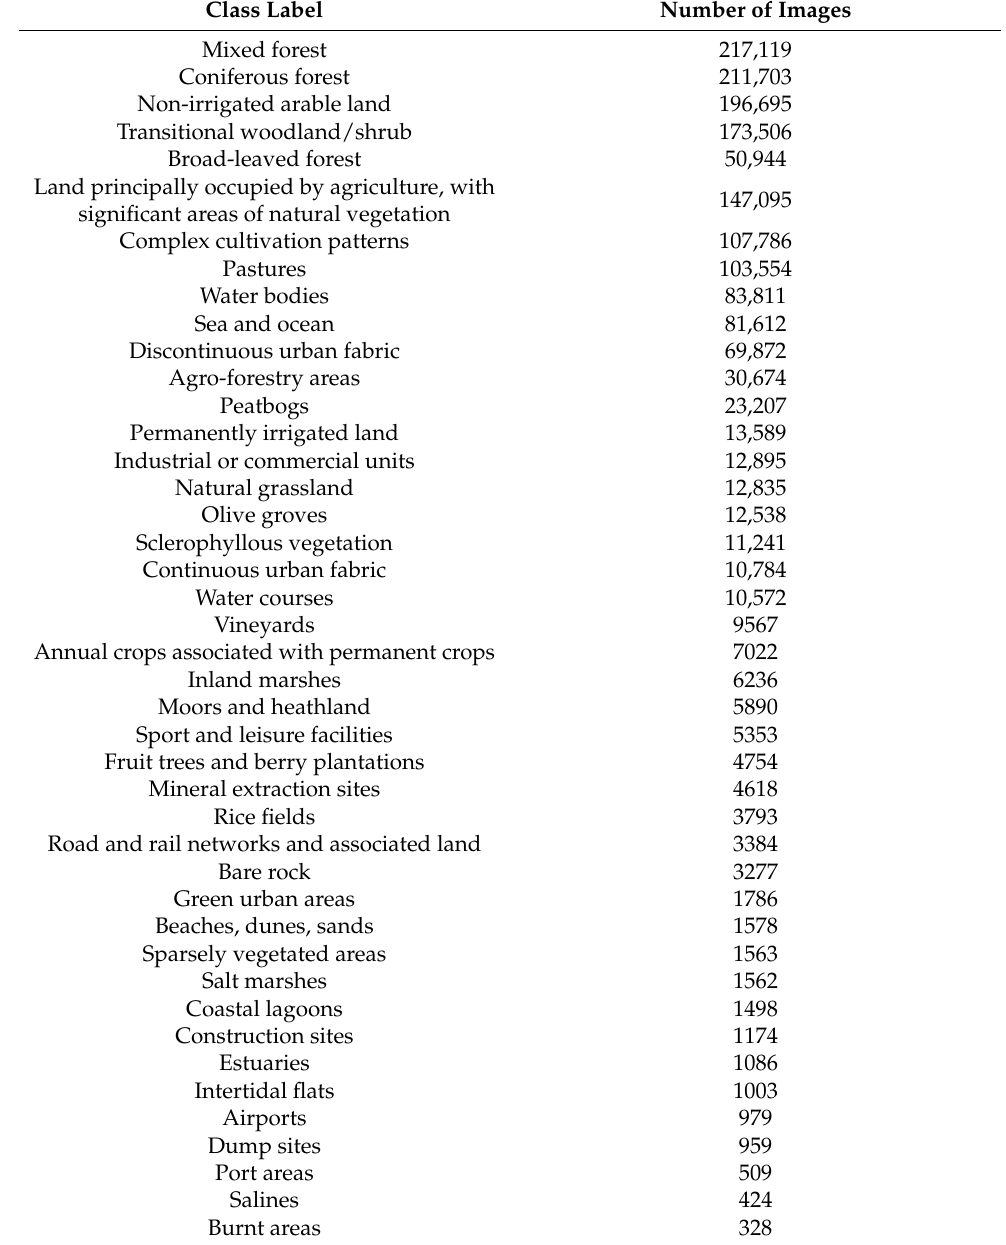
Table A2. Number of images associated with each land-cover class in BigEarthNet.